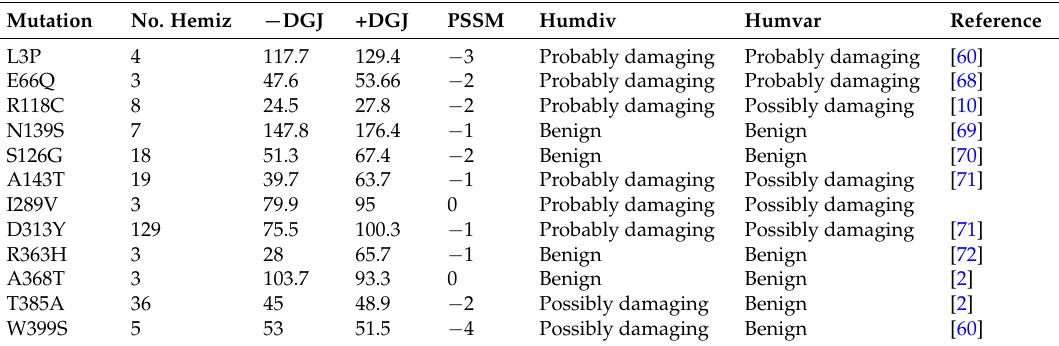
Table 2. Putative non-pathological AGAL mutants: features and residual activity in vitro.